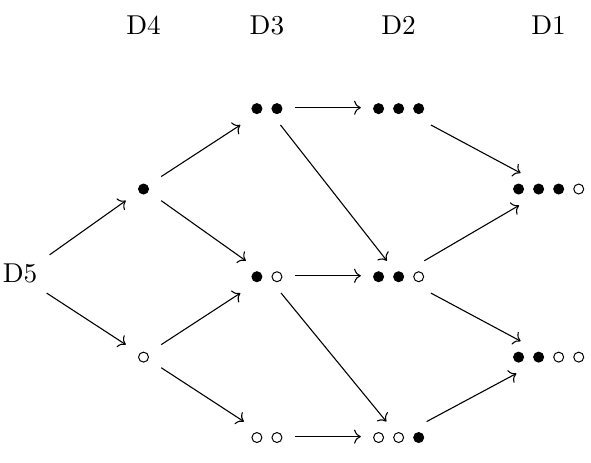
Figure 1 . Duality web of the theory on the D5 brane. A (cid:12)lled dot indicates a T-duality in one of the directions x 2 ; x 3 ; x 4 , an empty dot indicates a T-duality in the direction x 0 ; x 1 ; x 5 (although we don’t consider T-duality along x 0 ) The order of the dots is irrelevant because T-duality is